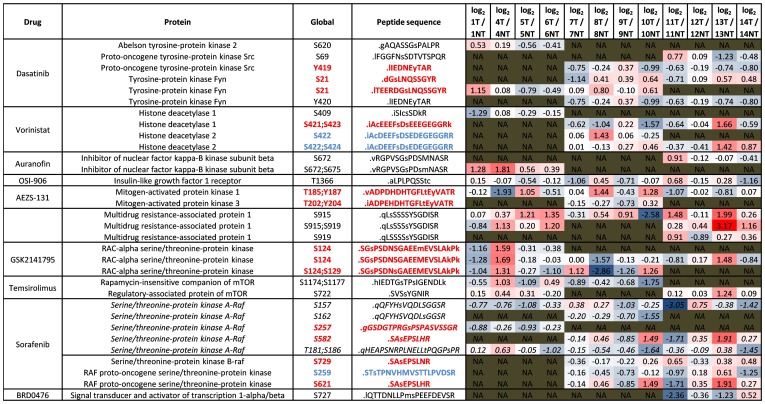
Phosphorylation indicates activity of drug targets.Here are examples of phosphopeptides that contain activator and inhibitor phosphorylation sites on proteins known to be anti-cancer drug targets. Here we display the inhibitory drug, the protein name, the global position of the phosphorylation site on the phosphoprotein, and the sequence of the phosphopeptide. The phosphorylated s/t/y residue in each peptide sequence is in lower case. The log2 T/NT ratios displayed in each case were median values calculated from all three arms of the workflow. Phosphopeptides in red contain activator phosphorylation sites, while phosphopeptides in blue contain inhibitor phosphorylation sites. Phosphopeptides in black contain phosphorylation sites with no known function.